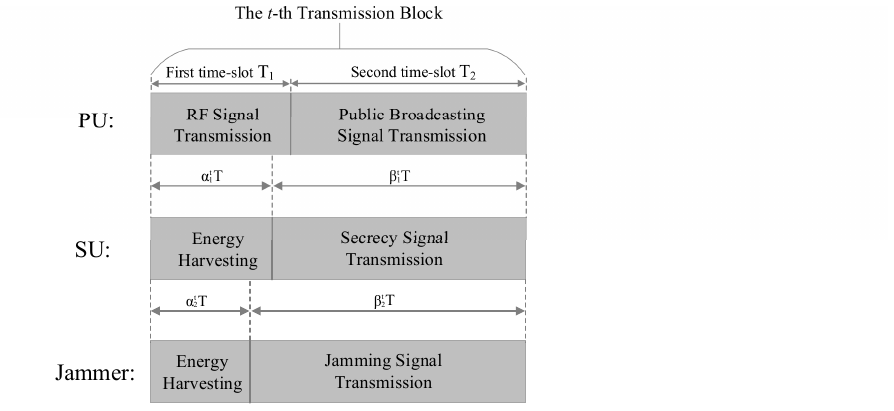
Figure 2. A two-phase EH transmission